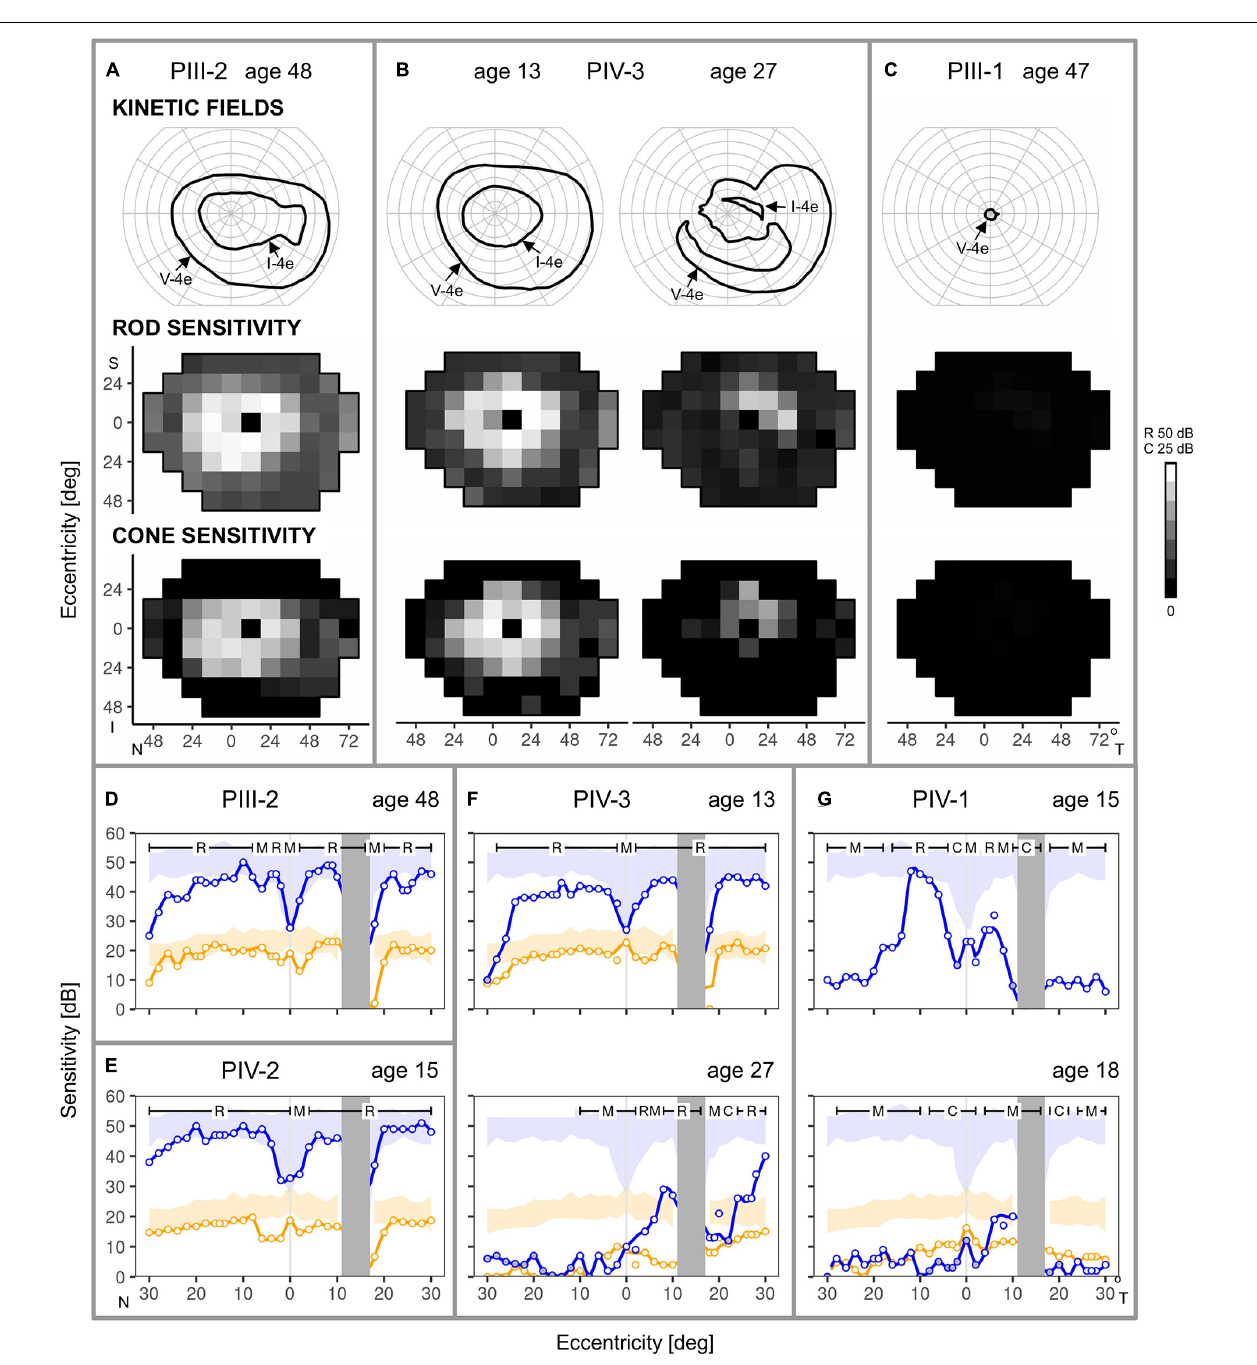
FIGURE 5 | Kinetic and chromatic static perimetry in the family members. (A) Full kinetic fields to V-4e but reduced to I-4e test targets in PIII-2 at age 48. Static perimetry shows rod and cone sensitivity is mildly reduced in a large region of central field but there is greater peripheral reduction. (B) Serial maps in PIV-3 at age 13 are comparable in pattern to those of PIII-2, but over the subsequent 14 years, there is loss of function in regions of the central field. (C) PIII-1, at a similar age to the sibling, PIII-2, has only a small residual central island of vision. (D–G) Rod and cone perimetric profiles across the horizontal meridian provide more detail of the central function. (D,E) PIII-2 and PIV-2, despite different ages at the visit, show rod and cone sensitivities at the lower limit of normal for most of the central 50 ◦ , but there is a decline of function at greater eccentricities. (F) PIV-3, at ages 13 and 27, show a sequence of change from central field rod and cone sensitivities at the lower limit of normal to loss of rod and cone function extending from the fovea into the nasal field but some retained peripapillary sensitivities. (G) PIV-1 from ages 15–18 shows impaired rod function at the earlier age to barely measurable rod function at the later age. Cone sensitivity was measured at age 18 only and it was abnormally reduced across the horizontal meridian. Blue: 500 nm target, dark-adapted; orange: 600 nm, light-adapted (10 cd.m − 2 white background); N, nasal; T, temporal; S, superior; I, inferior visual field; R, C, M, rod-, cone- and mixed (rod and cone) -mediated. Shaded areas: normal range ( ± 2SD).